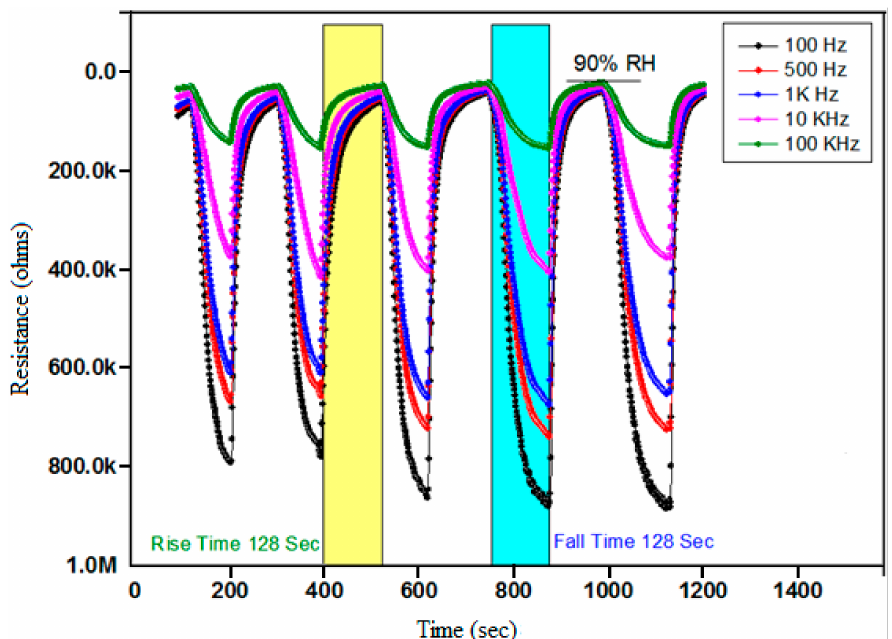
Figure 3. DTA/TGA results of humidity sensor of PVA polypyrrole composite thin film structure at five different frequencies and at changing RH from 30% to